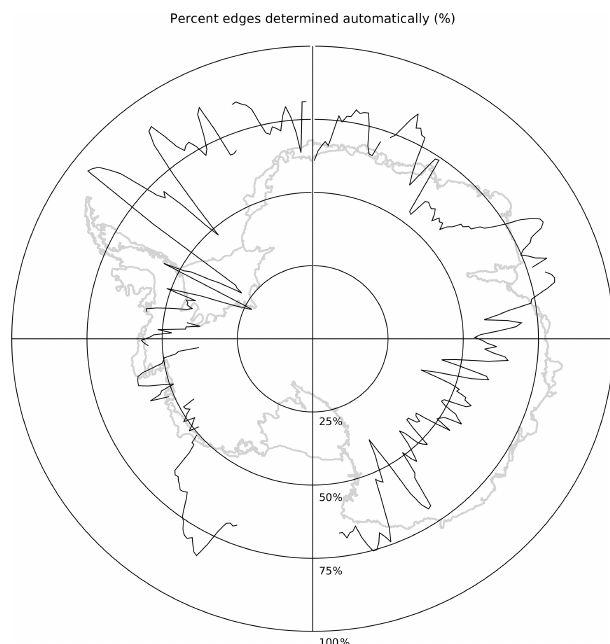
Figure 5. Polar plot showing the percentage of edges determined automatically, as a function of longitude. The Antarctic continent is outlined in grey for spatial context. To remove noise in regions with little fast ice, 1 ◦ longitude bins with fewer than 5000 total fast-ice edge pixels across the 18-year dataset were not